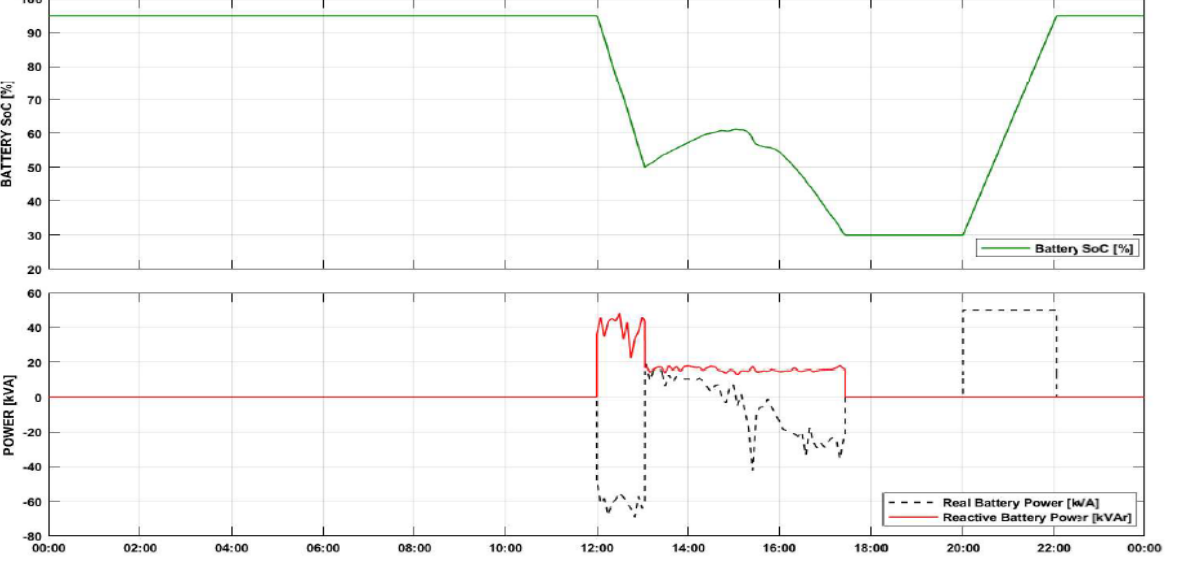
Figure 24. The behavior of MCAST micro-grid integrated with optimum-sized energy storage during an 8-h power cut at 8 p.m.